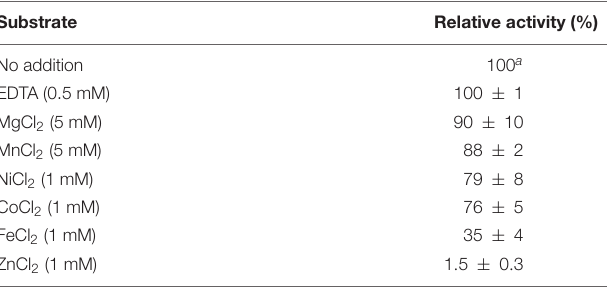
TABLE 2 | Influence of divalent cations on the activity of recombinant ( S )-3-hydroxybutyryl-CoA dehydrogenase Nmar_1028. Substrate Relative activity (%) No